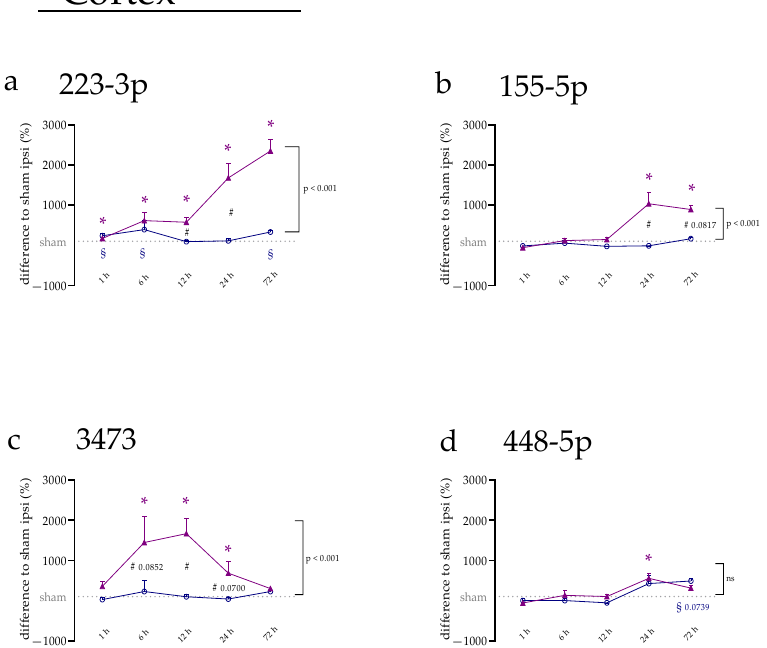
Figure 1. miRNA alteration in the cerebral cortex during the first three days after tMCAo. ( a ) miRNA levels of miR-223-3p, ( b ) miR-155-5p, ( c ) miR-3473, and ( d ) miR-448-5p of ipsi- (purple) and con- tralateral (blue) side of the cerebral cortex. Data are depicted as the difference in percentage (%) compared to the sham ipsi group ± SEM. (*) shows a significant difference between the ipsilateral side with sham ipsi; (#) shows a significant difference in the comparison of ipsi and contra at the specific time point; (§) shows a significant difference between the contralateral side with sham contra. Additionally, indicated on the side of the graph, there is the group difference between the ipsi- and contralateral hemispheres over the whole experimental set-up as calculated by two-way